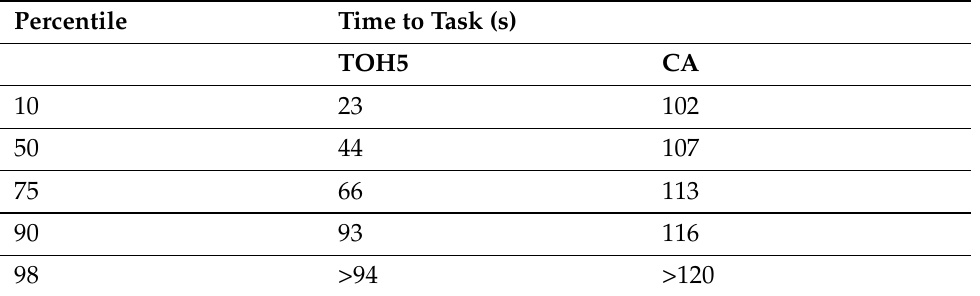
Table 8. Percentiles in Time to Task to resolve TOH5 and CA.